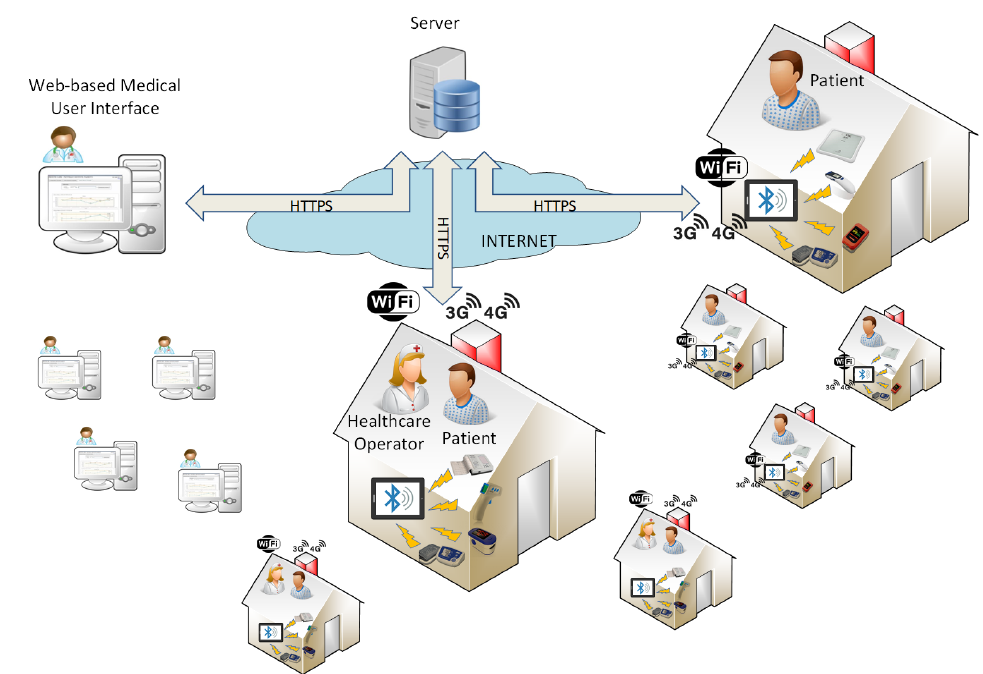
Figure 1. Architecture of the Tel.Te.Covid19 telemedicine